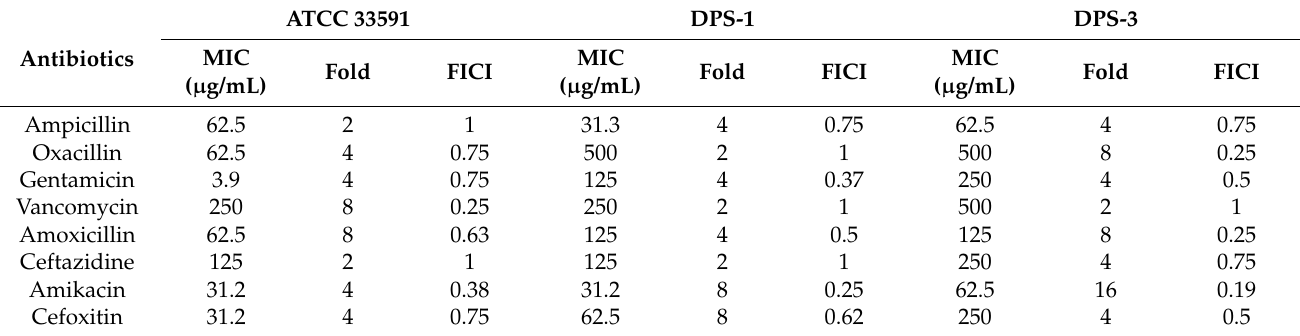
Table 1. The MIC value of conventional antibiotic and synergistic effect of TCA combined with an antibiotic. ATCC 33591 DPS-1 DPS-3 Antibiotics